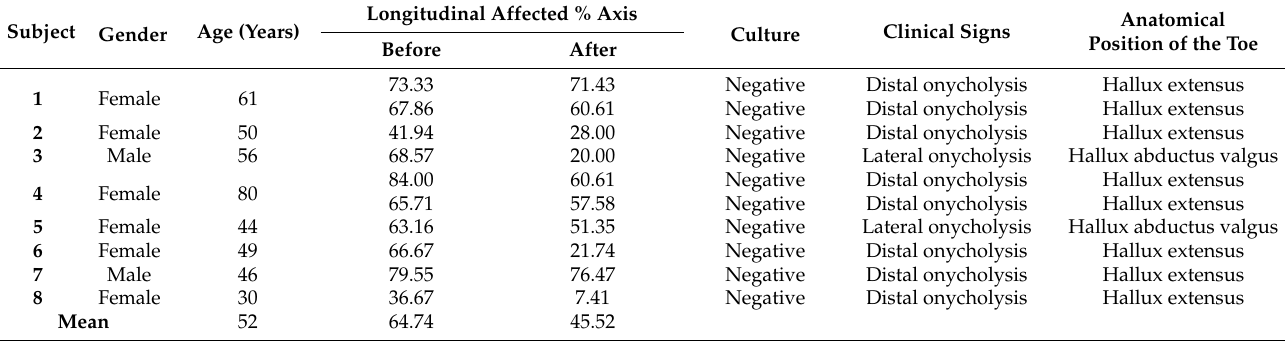
Table 1. Detailed results by